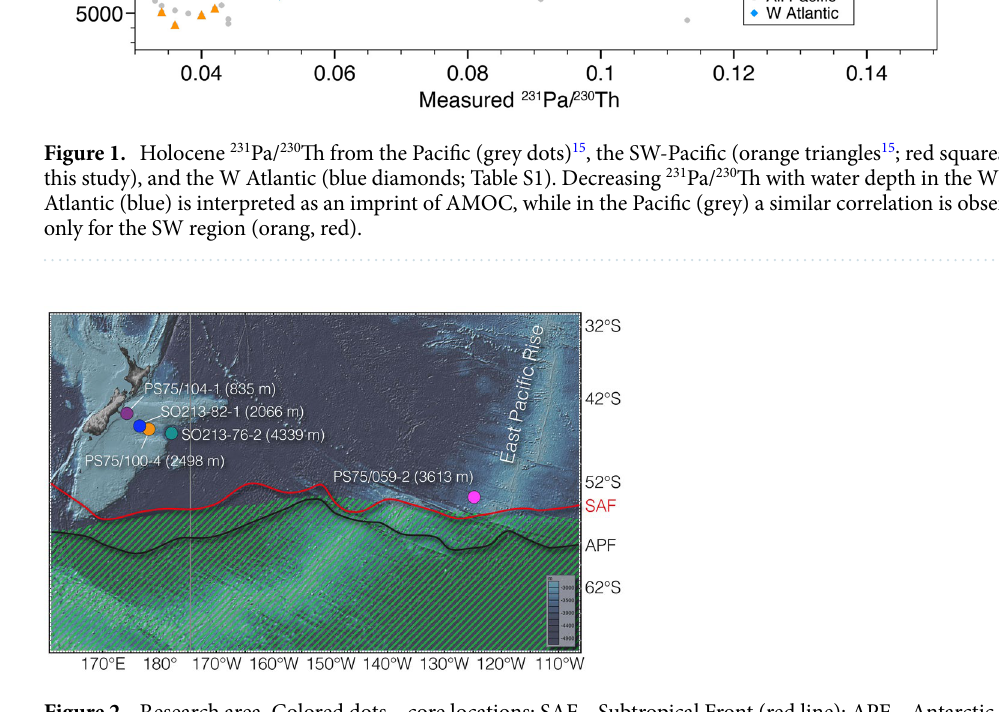
Figure 2. Research area. Colored dots—core locations; SAF—Subtropical Front (red line); APF—Antarctic Polar Front (black line) 68 ; Green shading—opal belt. Vertical grey line—section used in Fig. 6. Map created with GeoMapApp 3.6.12 (http:// www. geoma papp.